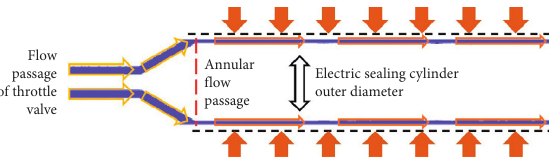
Figure 4: Change of the flow area of the annular flow passage.